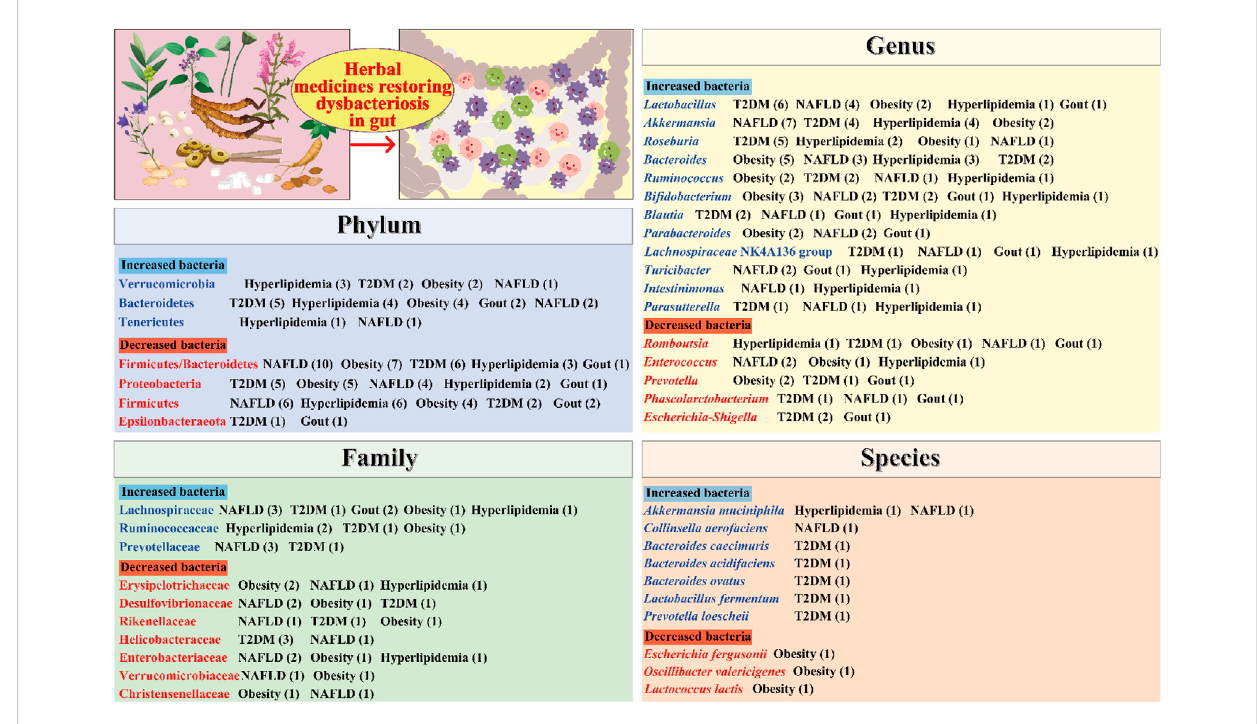
FIGURE 1 Herbal medicines regulate the composition of the gut microbiota. The numbers in parentheses represent the number of current studies on herbal remedies for the corresponding metabolic diseases. T2DM, type 2 diabetes mellitus; NAFLD, non-alcoholic fatty liver disease.